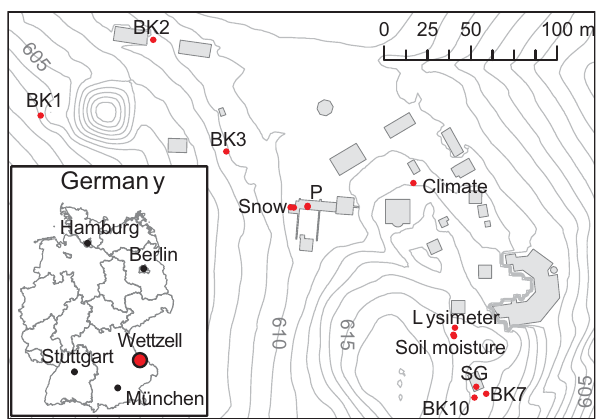
Fig. 2. Study area with the different hydrological sensors and the topography represented by contour lines (distance 1m). Location of Wettzell in Germany and some major cities are displayed in the inset